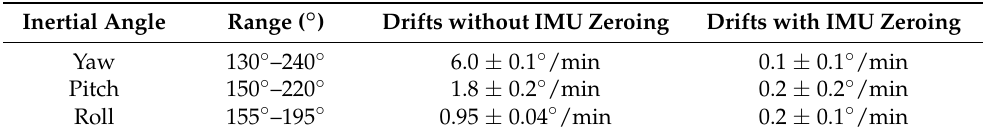
Table 2. Experimental angular ranges and time drifts of inertial angles without and with IMU